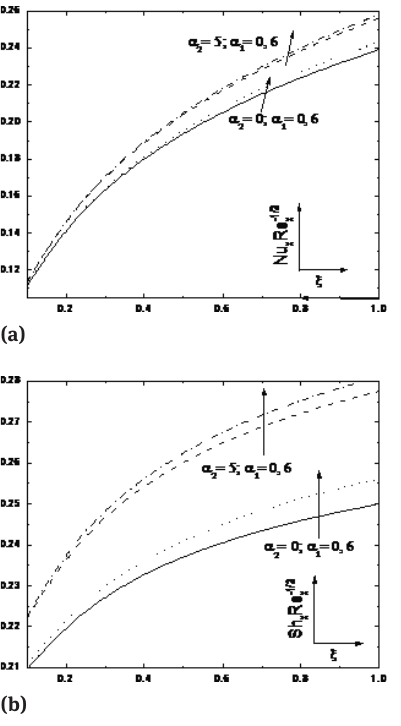
Fig. 6: The effect of Nonlinear temperature and concentration pa- rameters on (a) local Nusselt number, (b) local Sherwood number for Δ = 0.5, Fs = 0.5, Ω = π /6, Bi = 0.5.